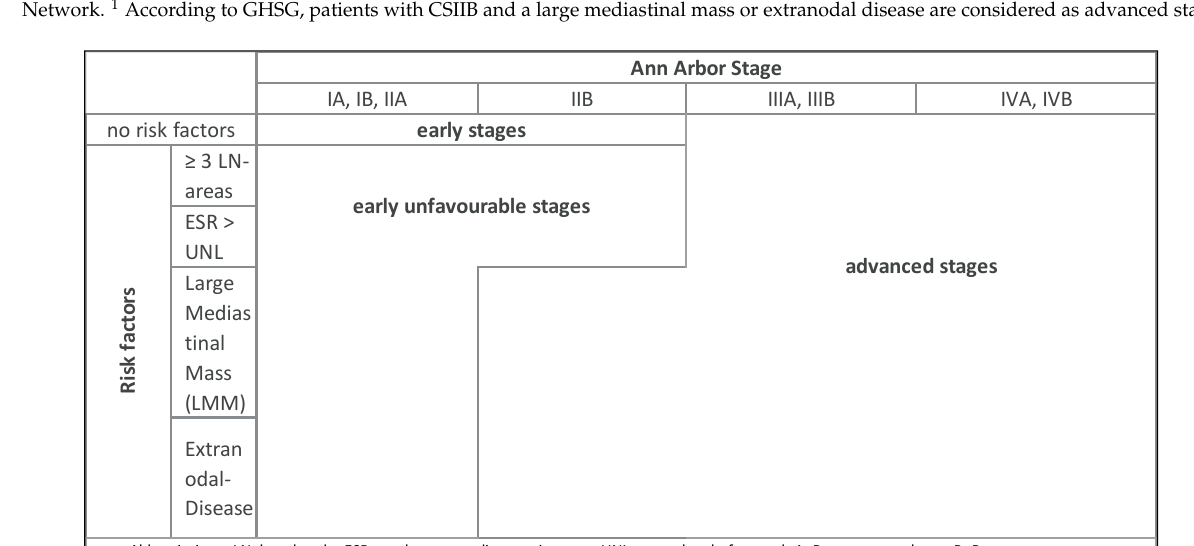
Figure 1. Risk-stratified staging according to risk factors and Ann Arbor stage.